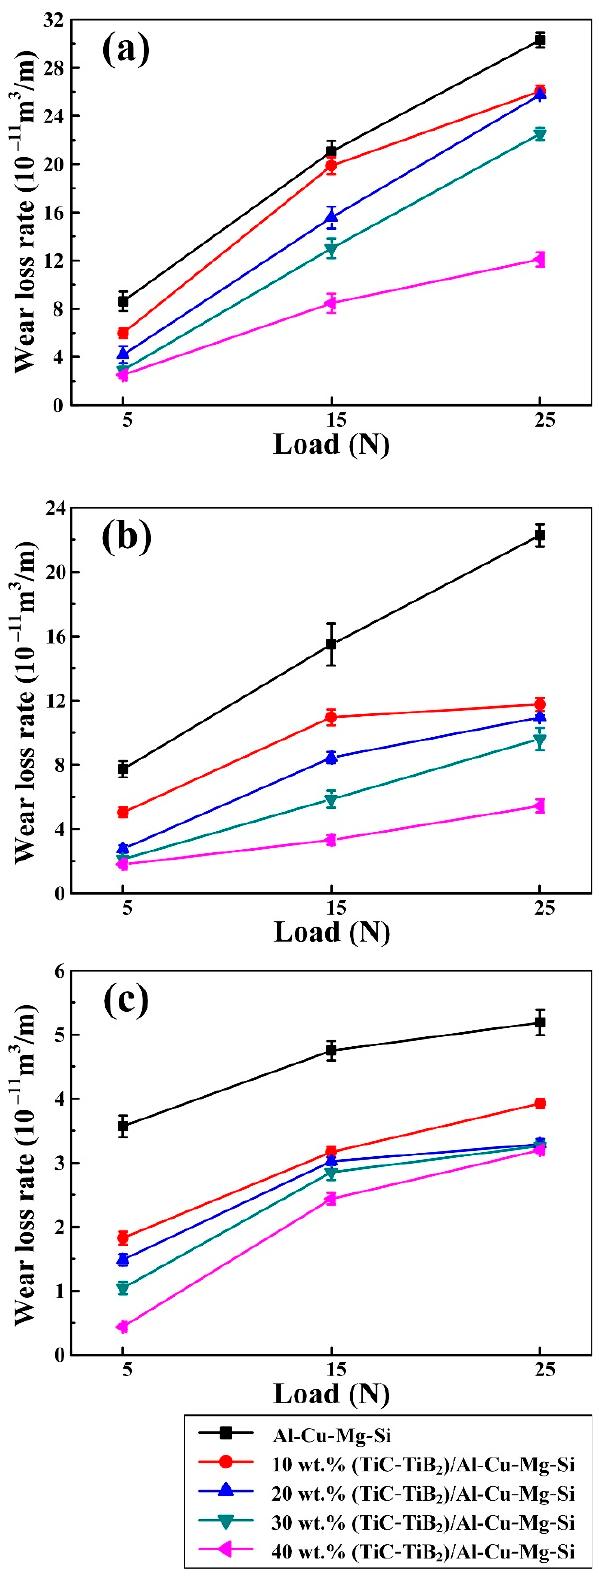
Figure 8. Wear rate vs. applied load under Al 2 O 3 abrasive size of ( a ) 40 µ m, ( b ) 23 µ m and ( c ) 13 µ m for the Al-4.7Cu-0.32Mg-0.44Si alloy and (TiC-TiB 2 )/Al-4.7Cu-0.32Mg-0.44Si composites. It is of note that, with increasing load from 5 N, to 15 N to 25 N, with an Al 2 O 3 abrasive size of 23 μ m, the WRs of the 31.9 wt.% (20 vol.%) nano-TiC/Al-4.7Cu-0.32Mg-0.44Si com- posite increased from 5.84, to 10.73 to 11.21 [34], while the WRs of the 30 wt.% (TiC- TiB 2 )/Al-4.7Cu-0.32Mg-0.44Si composite increased from 2.11, to 5.86 to 9.60. This means that the dual-phased (TiC-TiB 2 )/Al-Cu-Mg-Si composite showed better abrasive wear re- sistance than the single-phased nano-TiC/Al-Cu-Mg-Si composite. In the abrasive wear process, an increase in applied load would contribute to an in- crease in the contact zone between the specimens and the abrasives [35]. The penetration ability of the Al 2 O 3 abrasives increased as well as the micro-ploughing efficiency, which caused the increases in the WRs for the matrix alloy and composites. This was confirmed by the worn surface, as shown in Figure 9; with severe plastic deformation, the grooves became deeper and wider in the matrix alloy and the composites when the applied load increased. It can be inferred that micro-ploughing was the main abrasive wear mechanism for the Al-4.7Cu-0.32Mg-0.44Si alloy and the (TiC-TiB 2 )/Al-4.7Cu-0.32Mg-0.44Si compo- sites at an Al 2 O 3 abrasive size of 40 μ m.